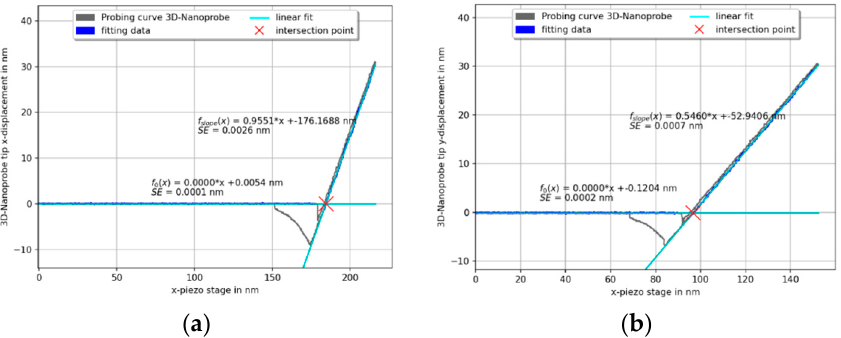
Figure 9. Two full probing curves (approaching and receding) from the bulk of the rigid support chip ( a ) and from the spring ( b ) of the reference spring; SE is the standard error of the slope.